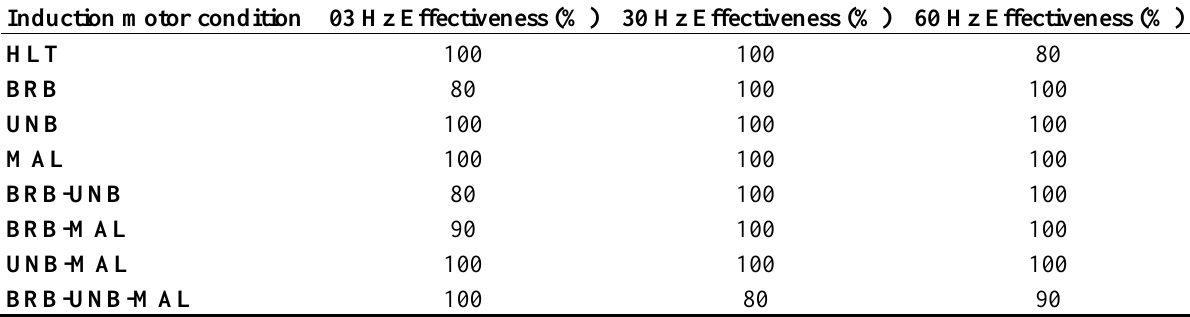
Table 2. Effectiveness of the proposed smart sensor on identifying the induction motor condition with one or multiple combined